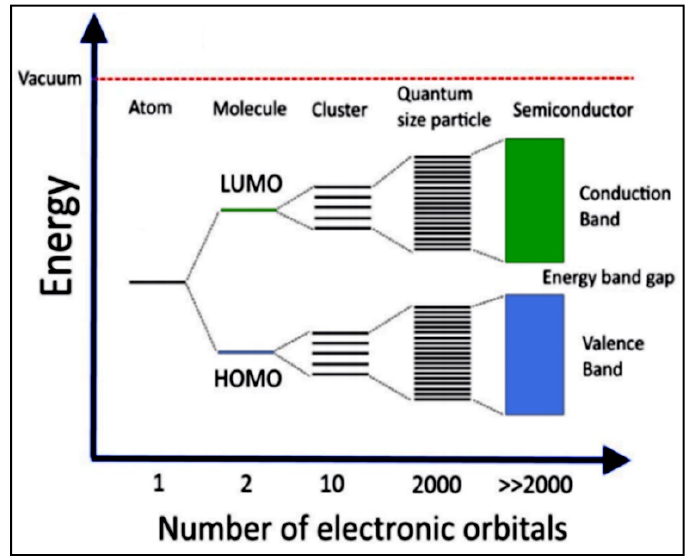
Figure 2. Band structure of a semiconductor as an interaction of atomic orbitals. adapted from reference [144]. Copyright 1997 Elsevier B.V.